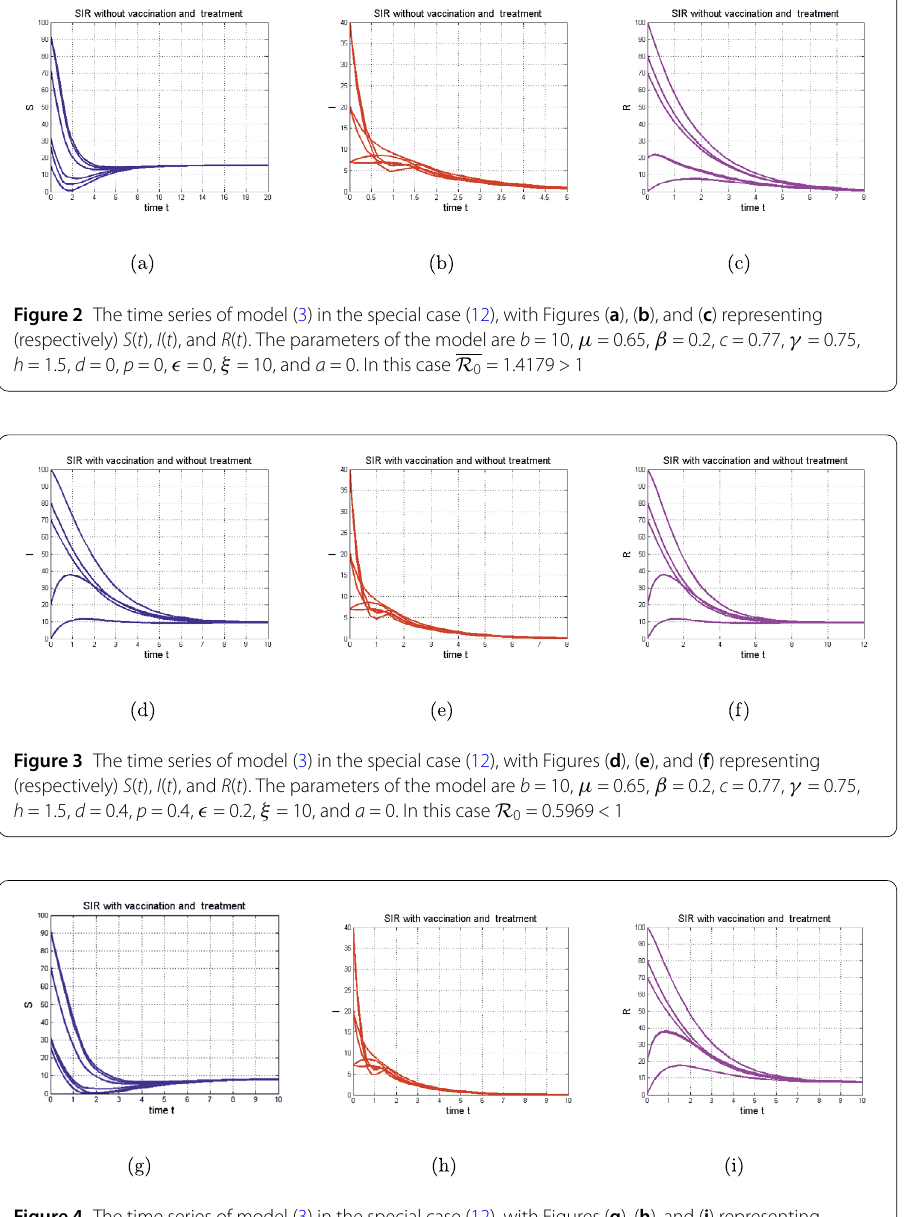
Figure 4 The time series of model (3) in the special case (12), with Figures ( g ), ( h ), and ( i ) representing (respectively) S ( t ), I ( t ), and R ( t ). With the same parameters as in Fig. 3 except p = 0.3, (cid:4) = 0.2 and d = 0.3 and a = 0.5. In this case, R 0 = 0.5993 <